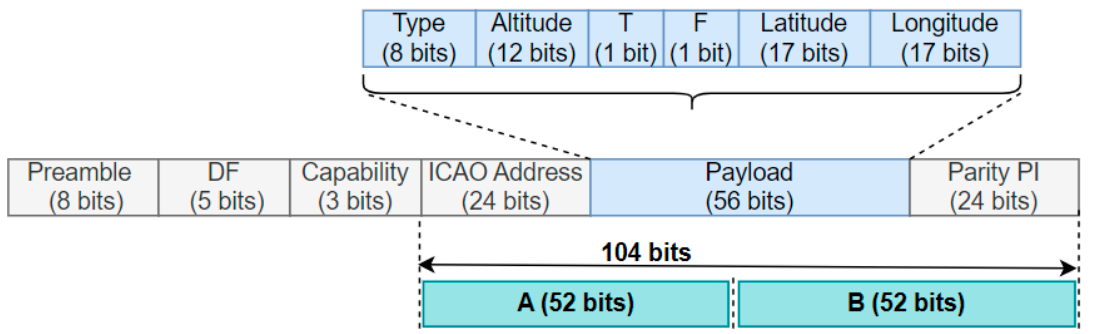
Figure 2. ADS-B message structure and split to use as FFX input